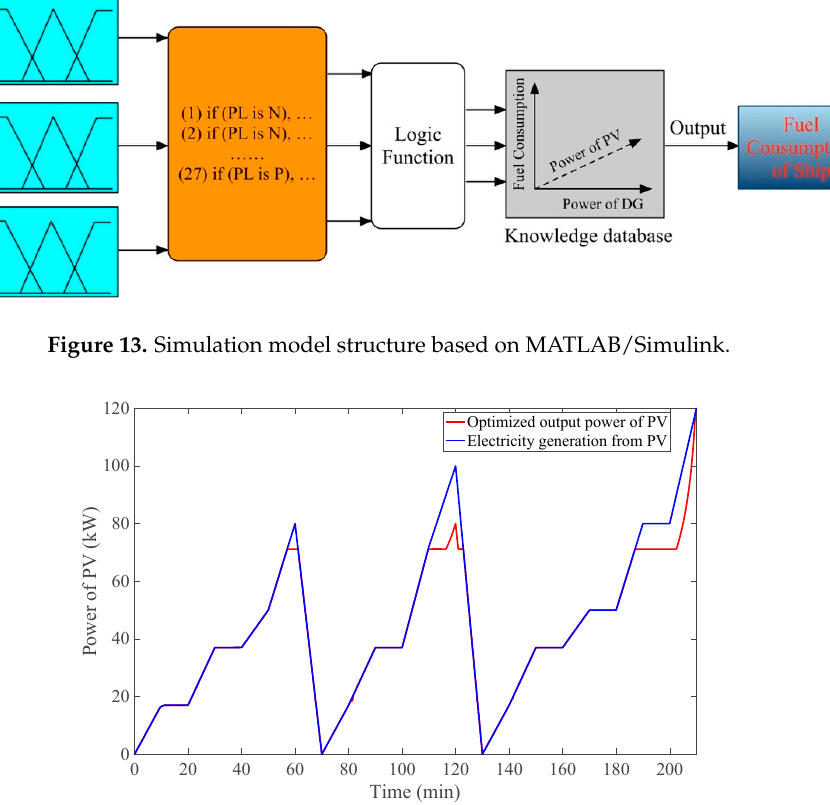
Figure 14. Output Power of the optimized solar system.